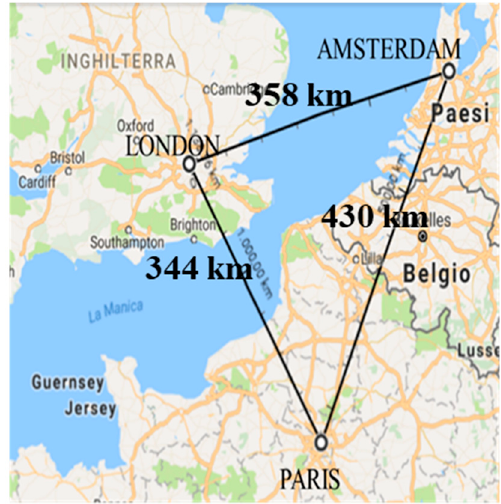
Figure 1. Northern European Area and distances between landmarks. Illustration from Google Maps (https://maps.google.com, accessed on 6 September 2022).